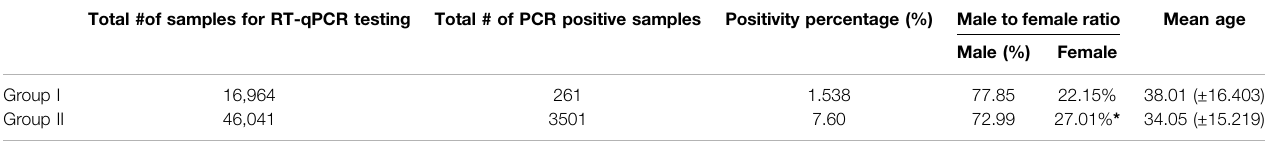
TABLE 3 | Demography of sample population and the variants of concern in Karachi,